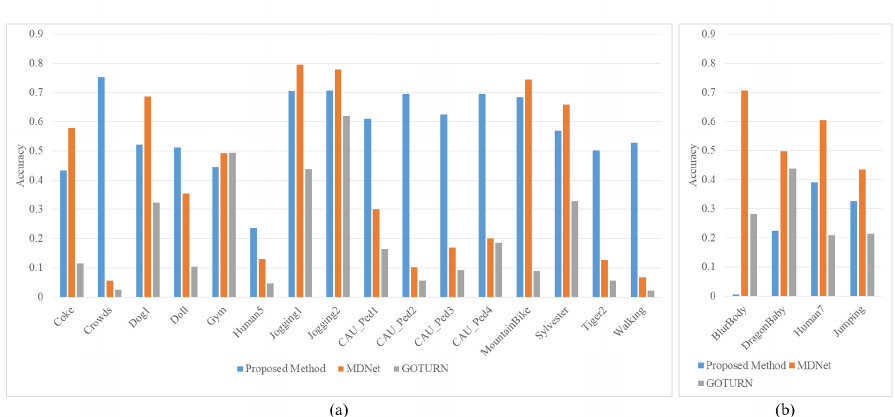
Figure 10. Accuracy evaluation of the proposed method, MDNet-based tracker and GOTURN-based tracker under a streaming condition. ( a ) Datasets in which significant target movements or challenging scenes exist. ( b ) Datasets in which no significant target movements and challenging scenes